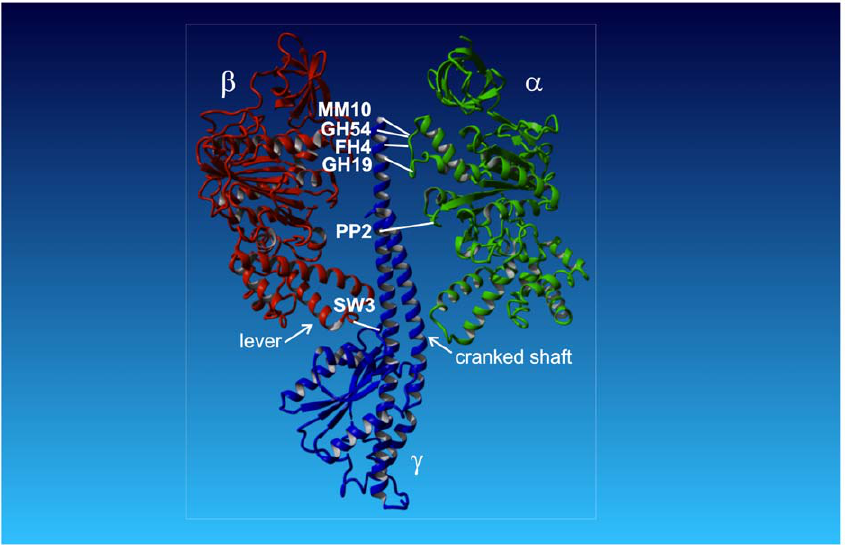
Figure 1. Model of E.coli F-ATPase. The model shows subunits a (green), b (red), and c (blue), and the cross-link positions between subunits c and a / b . For the sake of clarity subunit c and only one copy each of subunit a and b are shown. Subunits d and e are omitted. The white lines show the positions of the cross-link sites in the respective mutants. Due to the three-fold symmetry subunit c can form a cross-link with any of the three copies of a / b (original named E, DP, and TP [1]), the exact a / b subunit is not relevant for our experiments. The arrows indicate the positions of the lever with the DELSEED-sequence in subunit b , and the cranked shaft of the coiled coil in subunit c . Throughout the text the C-terminus of subunit c with cross-link position MM10 is referred as the top. The membrane embedded F O with the c-ring (not shown) connect to the globular portion of subunit c at the bottom. In between is the middle region with the coiled coil a -helices. The structural model is based on PDB ID: 3OAA [3].